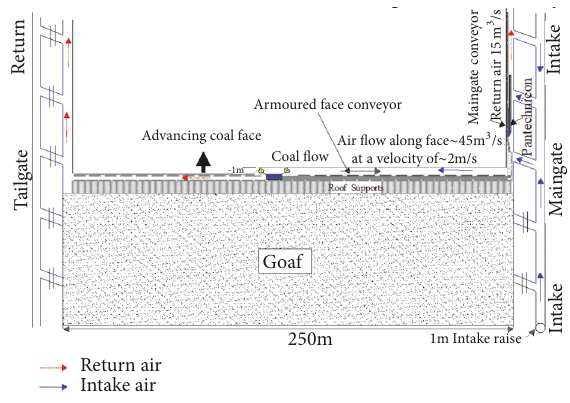
Figure 10: Partial homotropal ventilation